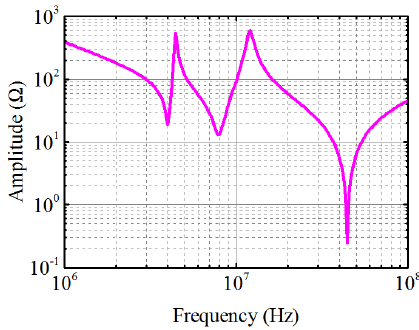
Figure 16. Frequency-domain characteristics of the DM circuit in HF range.